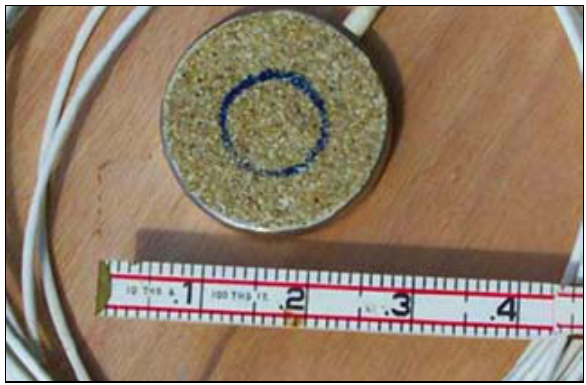
fig. 3. Stress transducers installed in experimental pavement